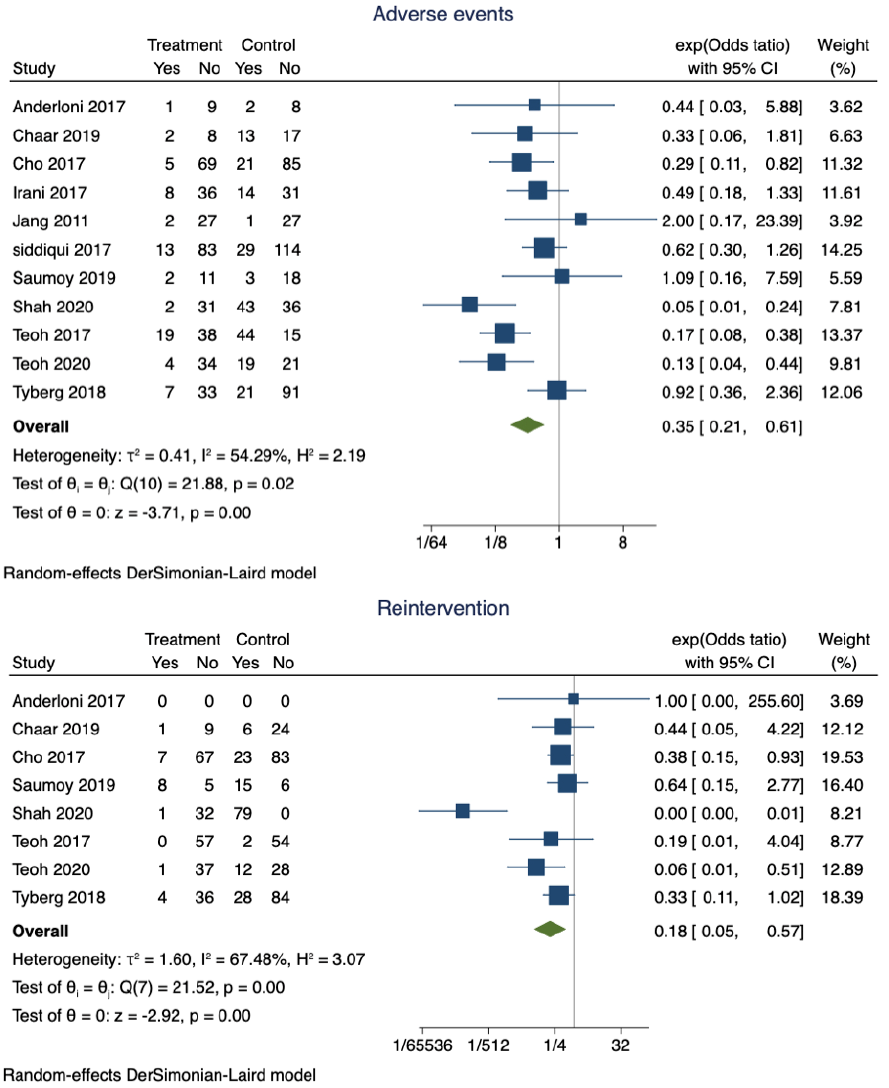
Figure 3. Forest plot for adverse events and reintervention rates. Table 2. Common complications associated with gallbladder drainage.